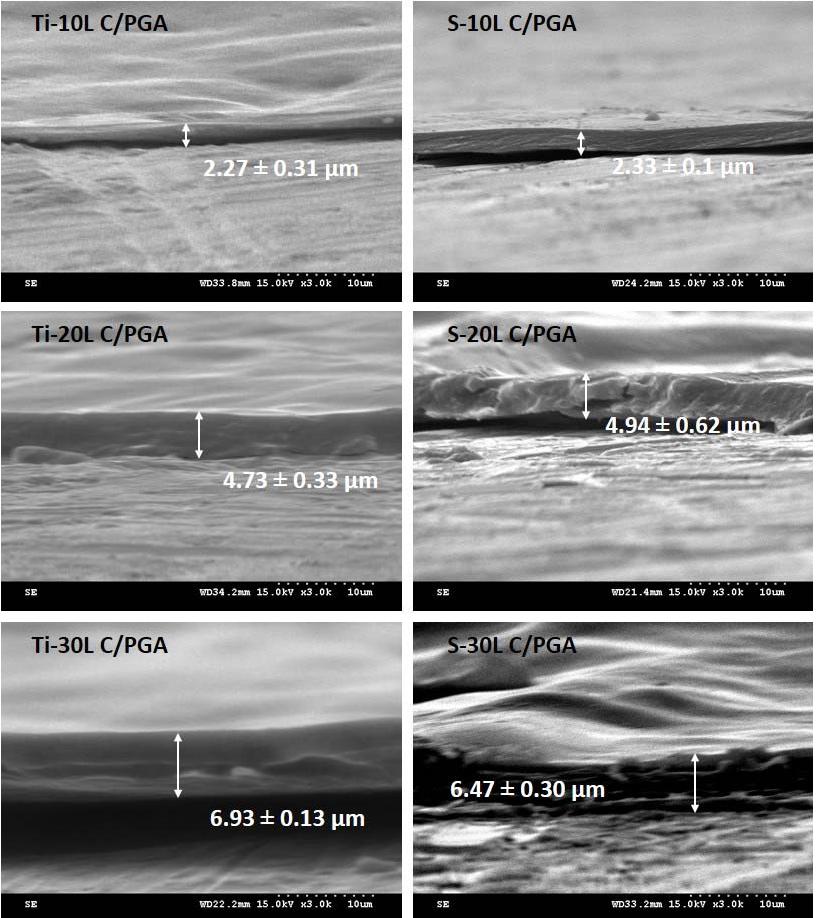
Figure 3. SEM cross-sectional images of different layers of C/PGA on Ti6Al4V and 316LSS substrates with the thickness of the coating measured. No statistical difference was found between Ti6Al4V and 316LSS substrates of the same number of layers.